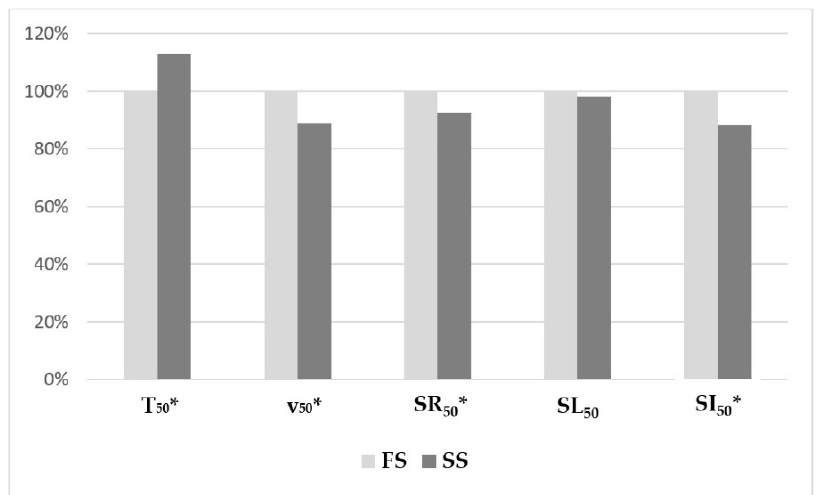
Figure 2. Values of indices in FS (faster swimmers) and SS (slower swimmers) groups for the 100 m freestyle race in percentages (the value for the FS group was assumed as 100%). T 100 —time of 100 m race, v 100 —mean velocity, SR 100 —mean stroke rate, SL 100 —mean stroke length, SI 100 —mean stroke index. *—difference between the FS and SS groups at p < 0.05.